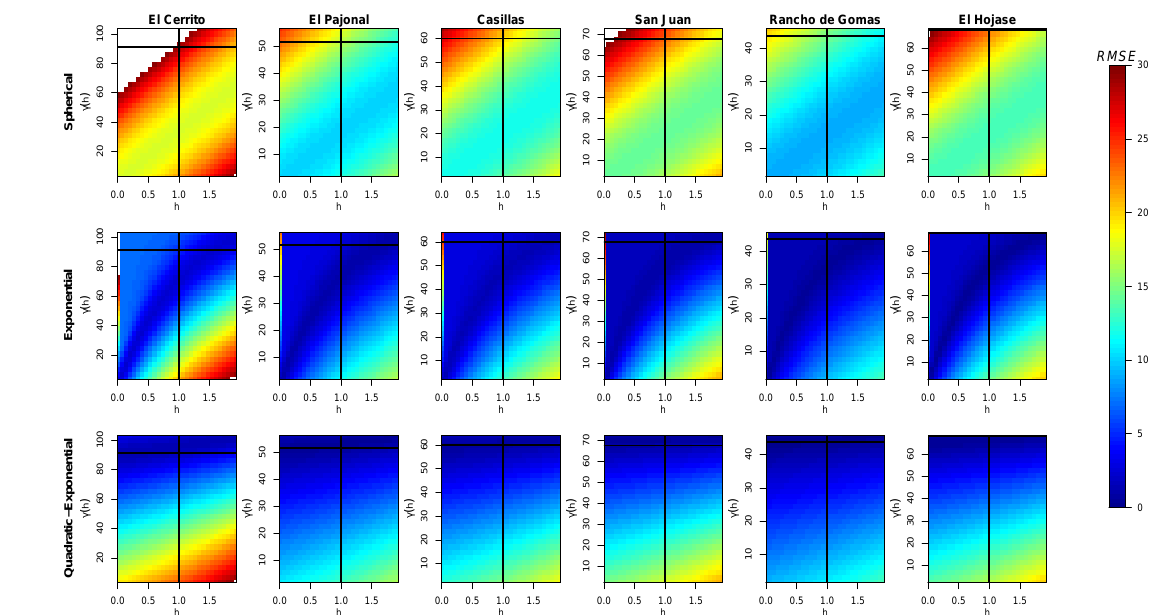
Figure 8. Obtained values of RMSE (color bar) for different pair of data ( r 0 , γ ( r 0 )) when fitting a curve for the variogram of each station with the three models and without considering the nugget effect. The intersection of the black solid lines tags the real R 0 . The white areas correspond to higher values than those shown on the color scale.